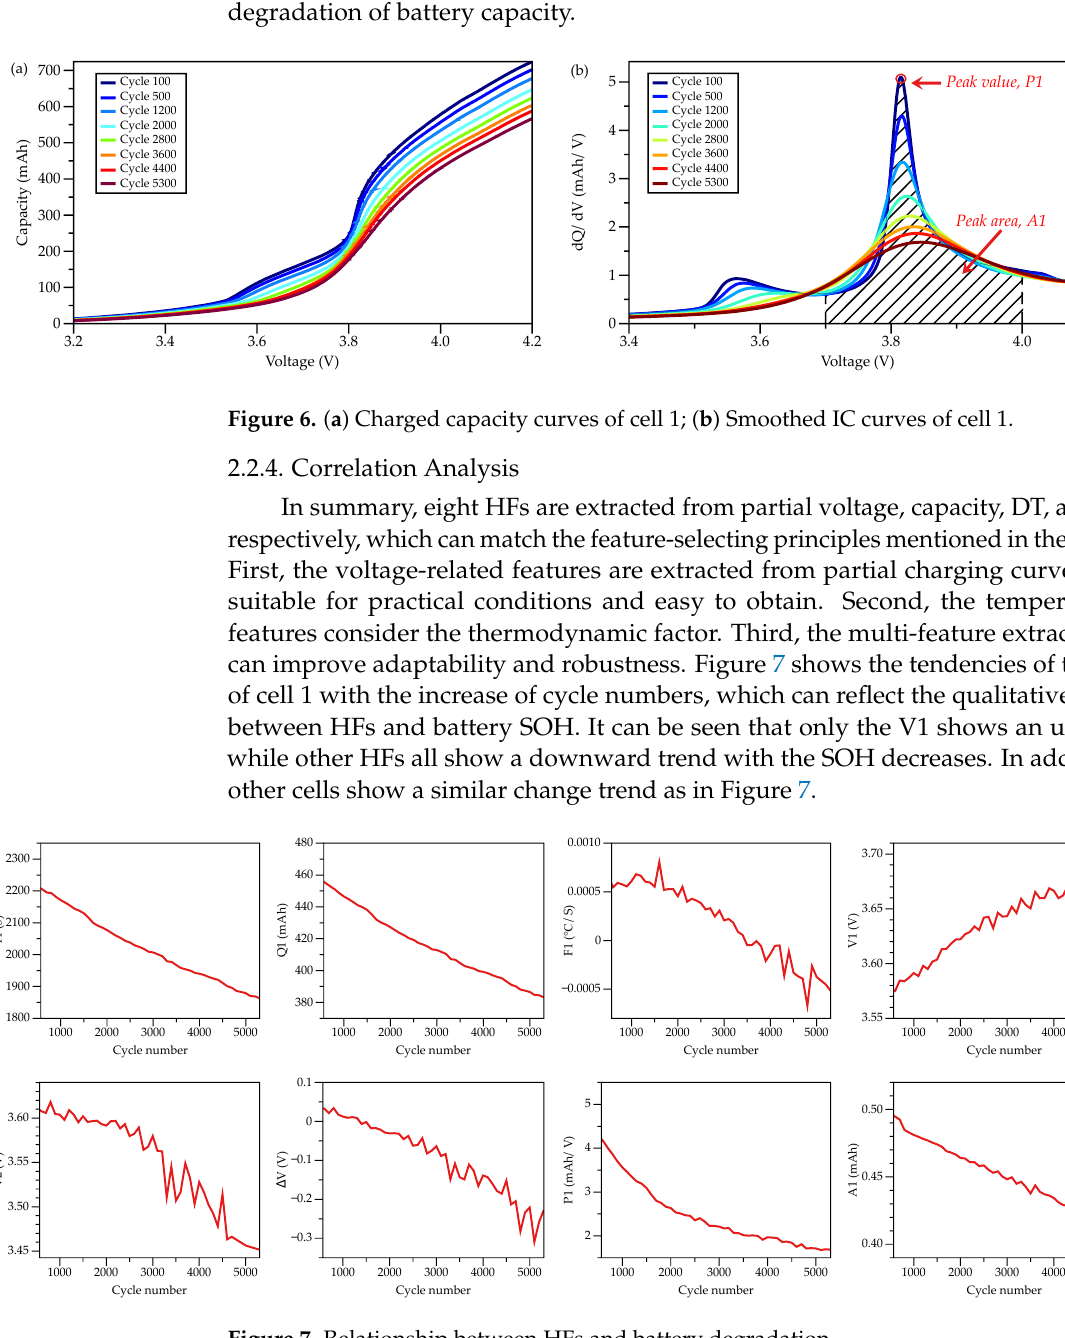
Figure 7. Relationship between HFs and battery degradation.